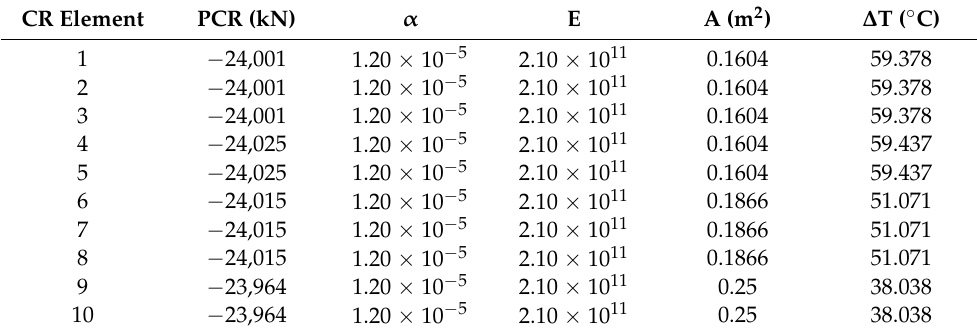
Table 4. Equivalent temperature difference of 1/4